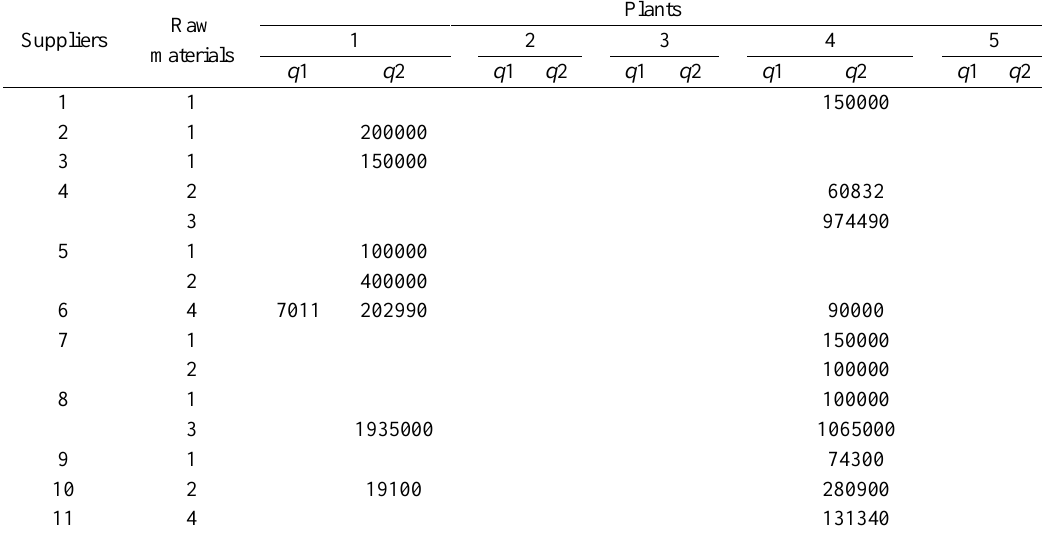
Table 8. Supplier selection and order allocation